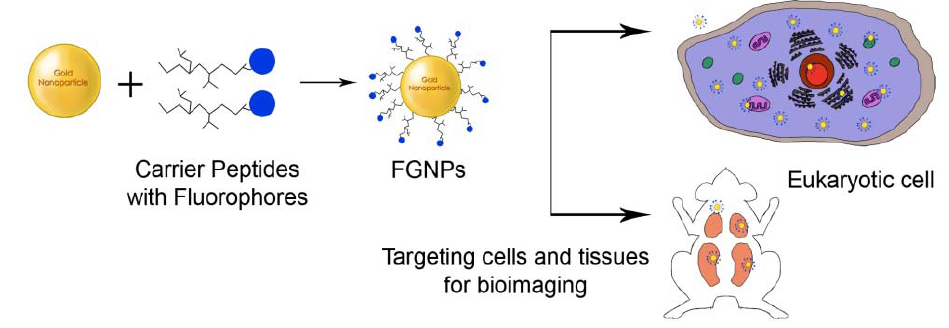
Figure 8. Gold nanoparticles functionalized with specific markers for Biodistribution